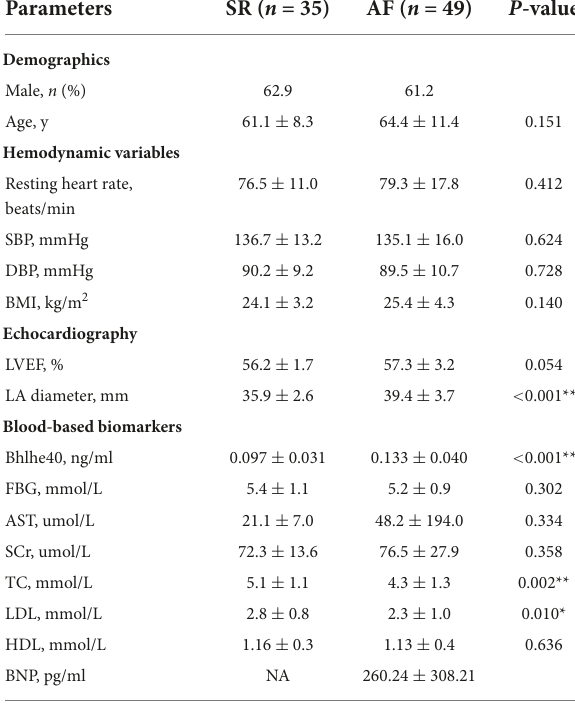
TABLE 2 Clinical characteristics.